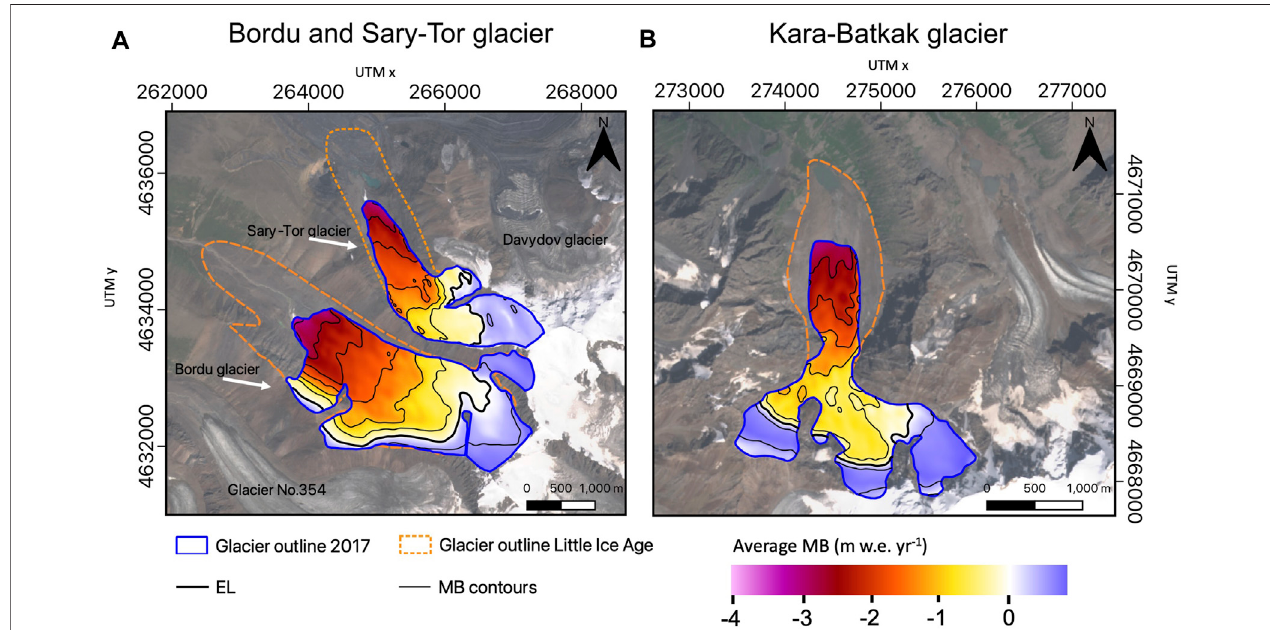
FIGURE 11 | Modelled average (of the years for which data is available) mass balance (MB) of the different glaciers. The thick black line indicates the average equilibrium line (MB (cid:1) 0). Contours are added for every 0.5 m w.e. yr − 1 . The satellite images are Sentinel-2 true colour images from August 11, 2019.